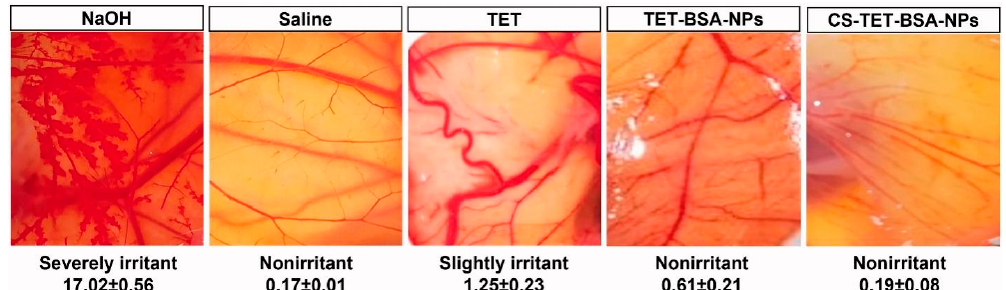
investigation after different treatments (TET: Tetrandrine suspension; TET-BSA-NPs: Tetrandrine loaded bovine serum albumin nanoparticles; CS-TET-BSA-NPs: Chitosan-coated bovine serum albumin nanoparticles containing tetrandrine). It highlights that the coating of chitosan over the bovine serum albumin nanoparticles is further helpful to reduce the ocular irritation index value compared to bovine serum albumin nanoparticles and tetrandrine suspension. Reproduced from Radwan et al. [45], Informa UK Limited,